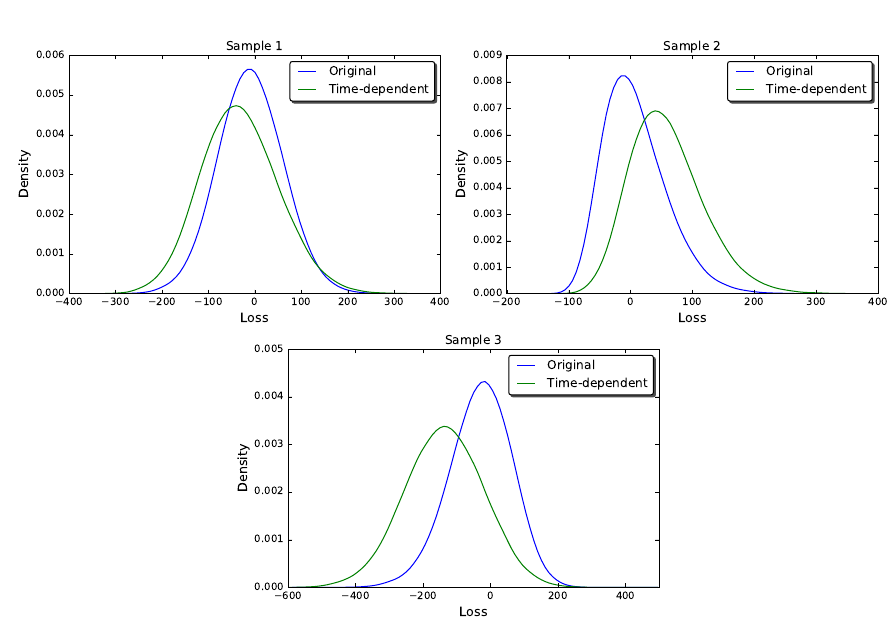
Figure 4. Probability density functions of the one-year loss distribution for a variable annuity with the GMAB rider, under the original and time-dependent risk-neutral measure. Scenario 1 = average initial volatility; Scenario 2 = low initial volatility; and Scenario 3 = high initial